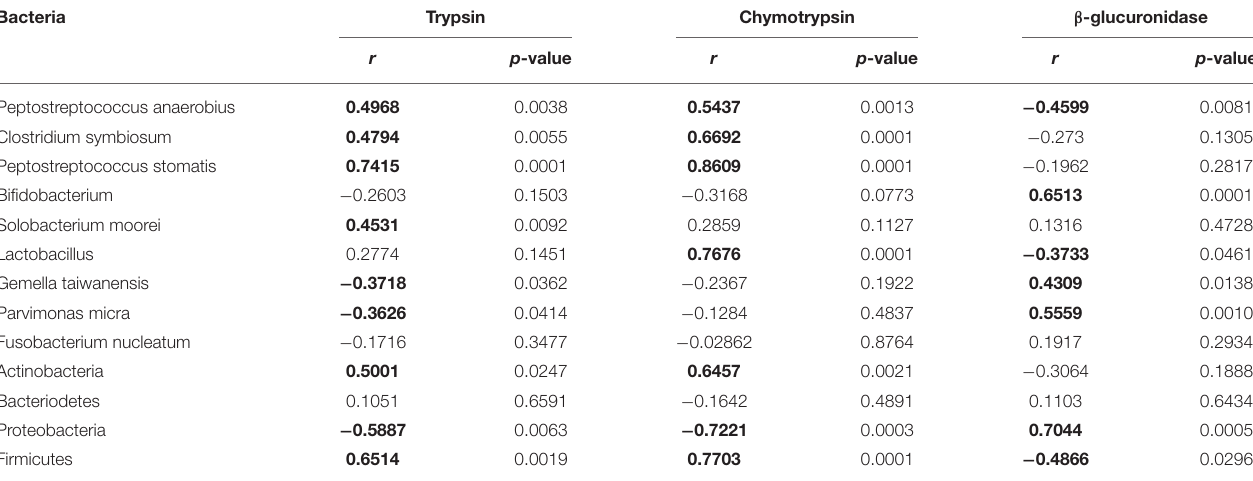
TABLE 2 | Correlation between CRC-associated bacterial abundances and trypsin, chymotrypsin, and β -glucuronidase.